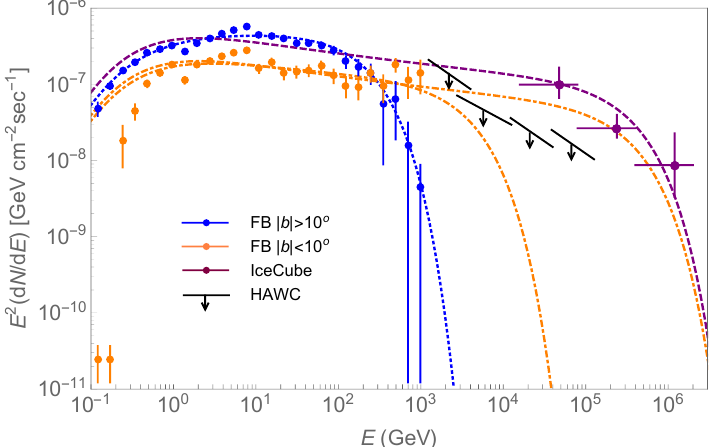
Figure 2. Fermi -LAT spectra from low- and high-latitude regions of the FB [23]. Also shown are HAWC upper limits in the b > 6 ◦ region [22] and neutrino spectra, assumed to be originated from the FB, from eight events [24]. The hadronic models with primary proton spectra ∝ E − k exp ( − E / E 0 ) are shown with lines for k = 2.0, E 0 = 1.6 TeV (blue dotted lines), k = 2.15, E 0 = 30 TeV, and k = 2.2, E 0 = 3 PeV (orange dot-dashed lines). The magenta dashed line correspond to the neutrino flux (all three flavors) for the model with k = 2.2, E 0 = 3